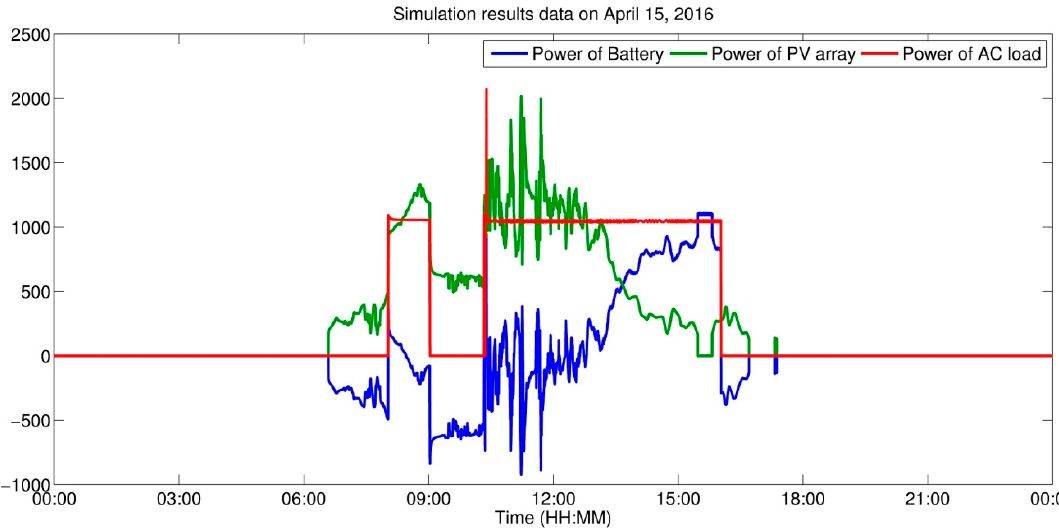
Figure 13. Power vs. time profiles obtained from simulation on HS model.